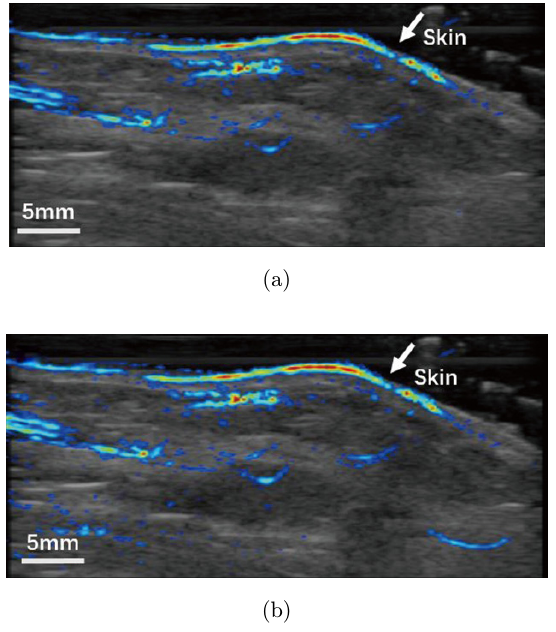
Fig. 8. (a) US/PA dual mode image without compensation of optical °uence. (b) US/PA dual mode image with compensa- tion of optical